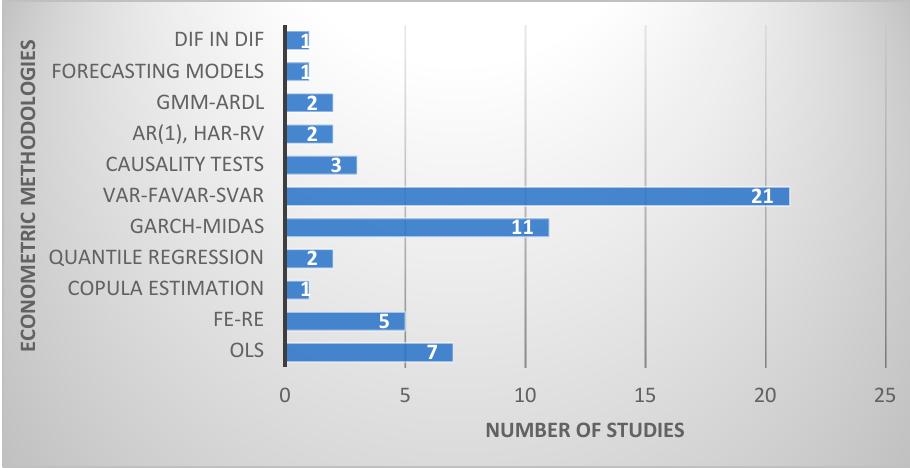
Figure 7. The econometric methodologies used in relation to the number of studies on the nexus between uncertainty and energy prices .